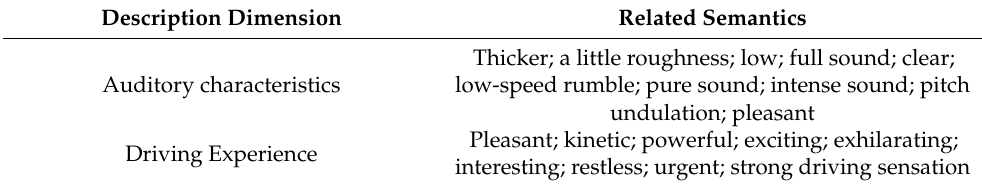
Table 1. Description of motion-sensitive sounds. Description Dimension Related Semantics Thicker; a little roughness; low; full sound; clear; Auditory characteristics low-speed rumble; pure sound; intense sound; pitch undulation; pleasant Pleasant; kinetic; powerful; exciting; exhilarating; Driving Experience interesting; restless; urgent; strong driving